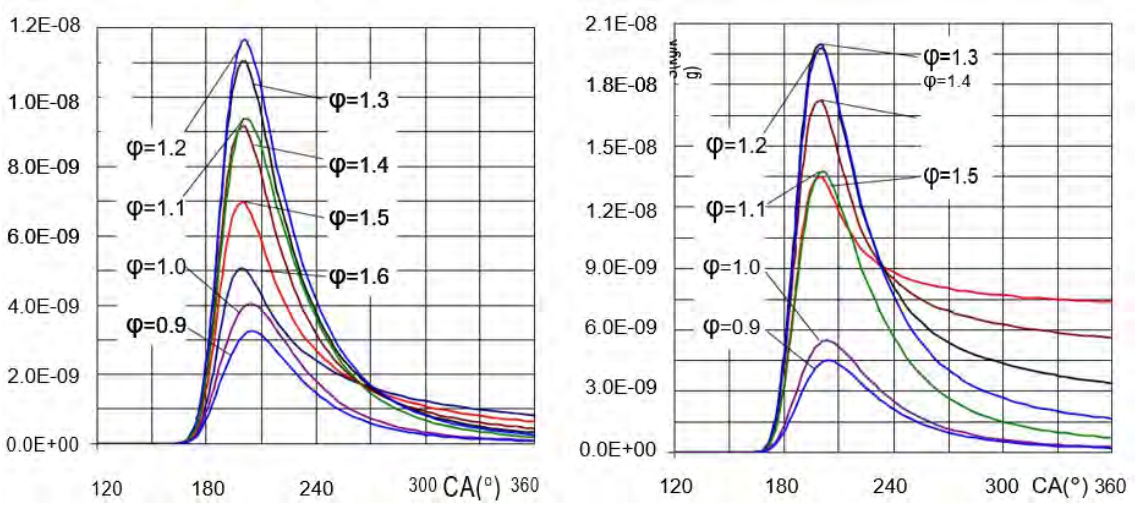
Figure 10. a: Effects of equivalence ratio on soot concentration (D15, n=2400rpm) b: Effects of equivalence ratio on soot concentration (D20, n=2400rpm)